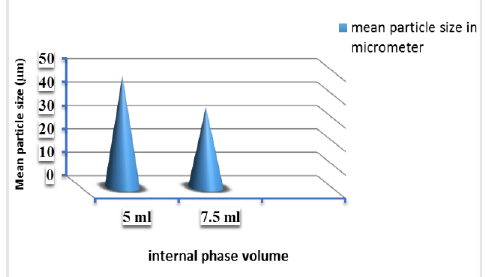
Figure (2) Histogram showing effect of internal phase volume on mean particle size